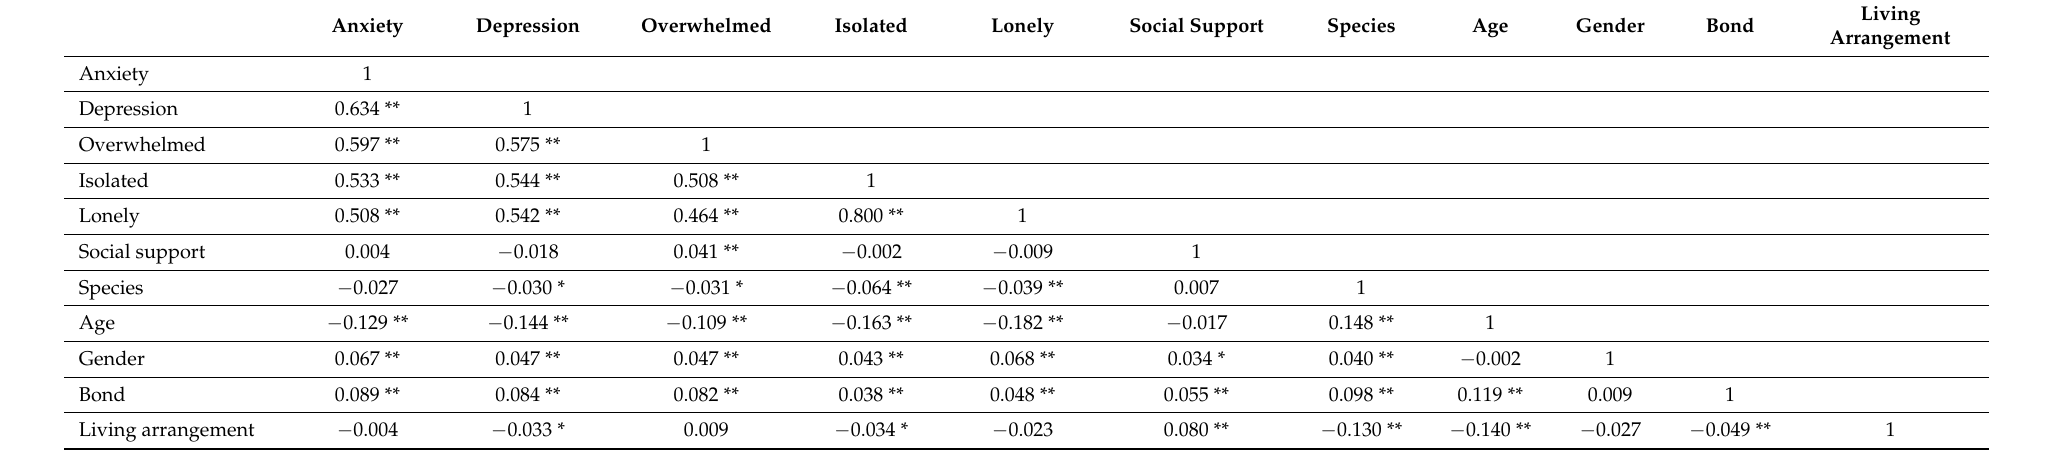
Table 4. Correlation matrix of negative emotions and potential predictive variables: social support, species, age, gender, bond, and living arrangement.